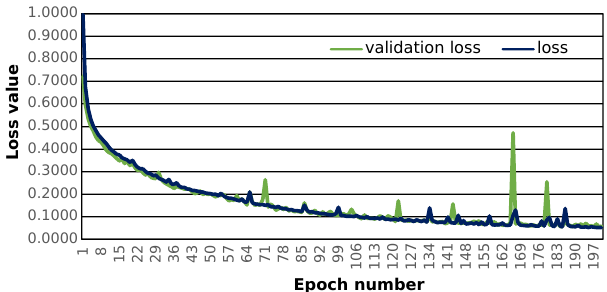
Figure 1. The training loss and validation loss during seq_to_seq model training. It follows the general rules of model training during time evaluation; both values are decreasing, indicating that the model is learning how to reconstruct the molecular sequence of the training molecules. It can be noticed that the loss value for the validation data also decreases, which means that the model learns to